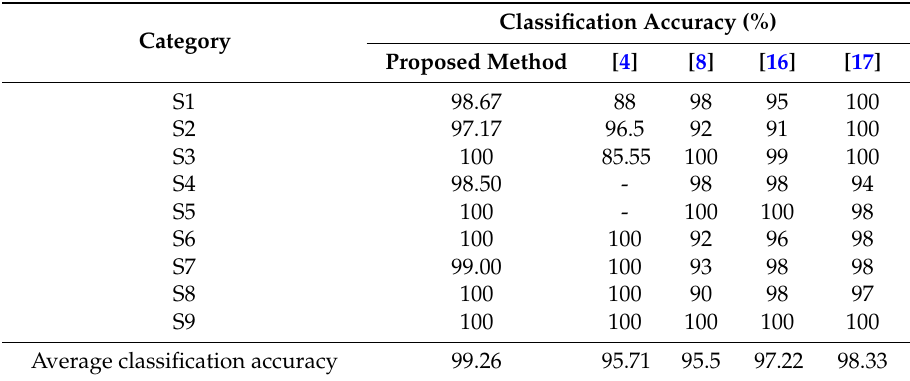
Table 4. Performance comparison in terms of percentage of correct classification results.